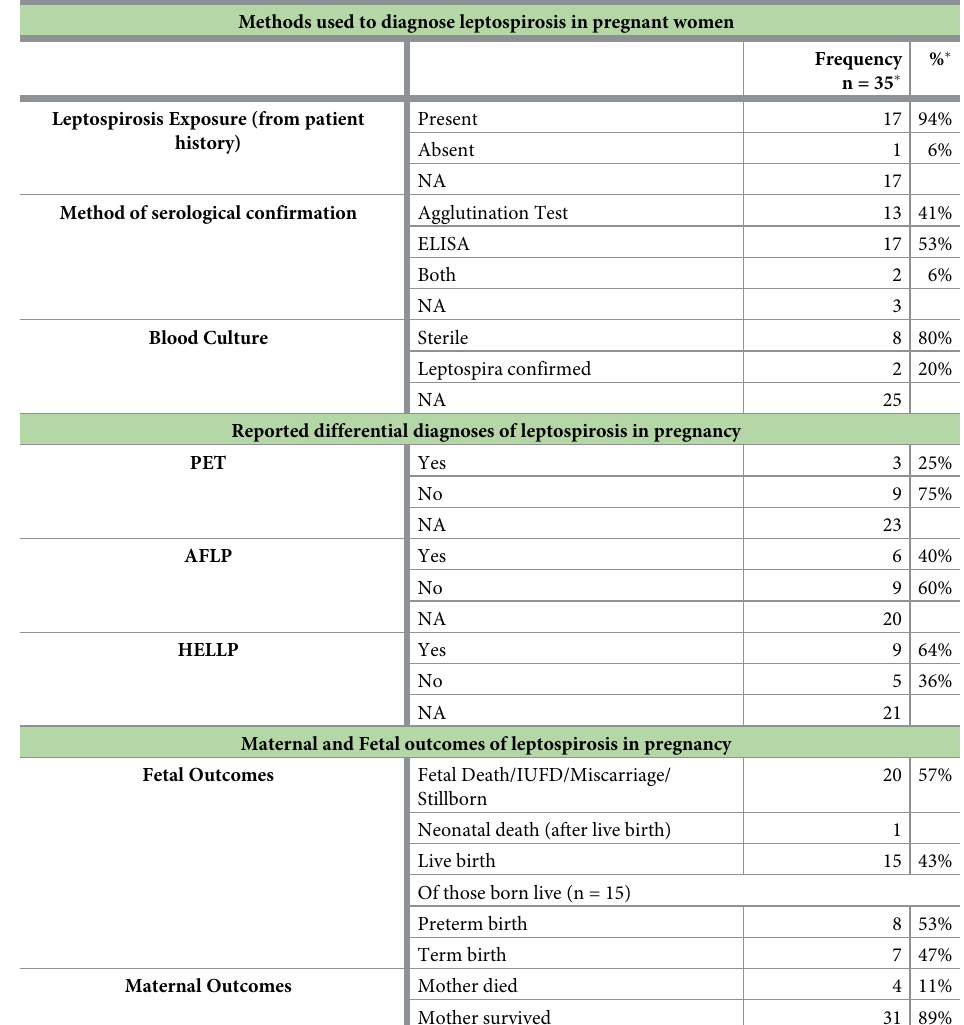
� Percentages were calculated after excluding missing data (NA); NA = Not Available; PET = Pre-Eclampsia; AFLP = Acute Fatty Liver of Pregnancy; HELLP = Haemolysis, Elevated Liver enzymes, Low